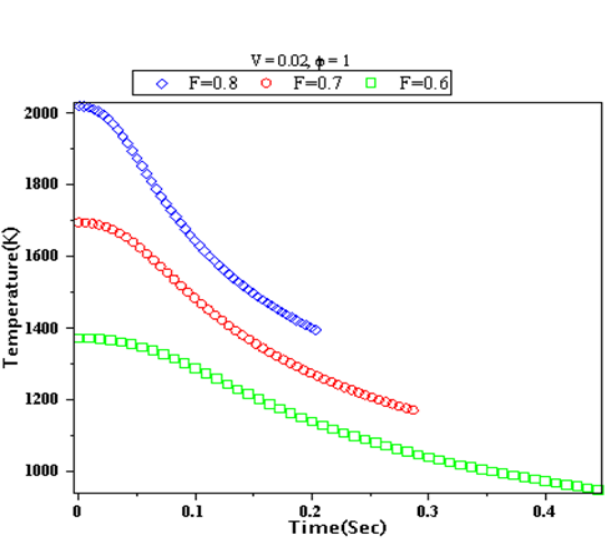
Fig. 5. Effect of radiation heat loss anf fuel volitility on flame tempera - ture.